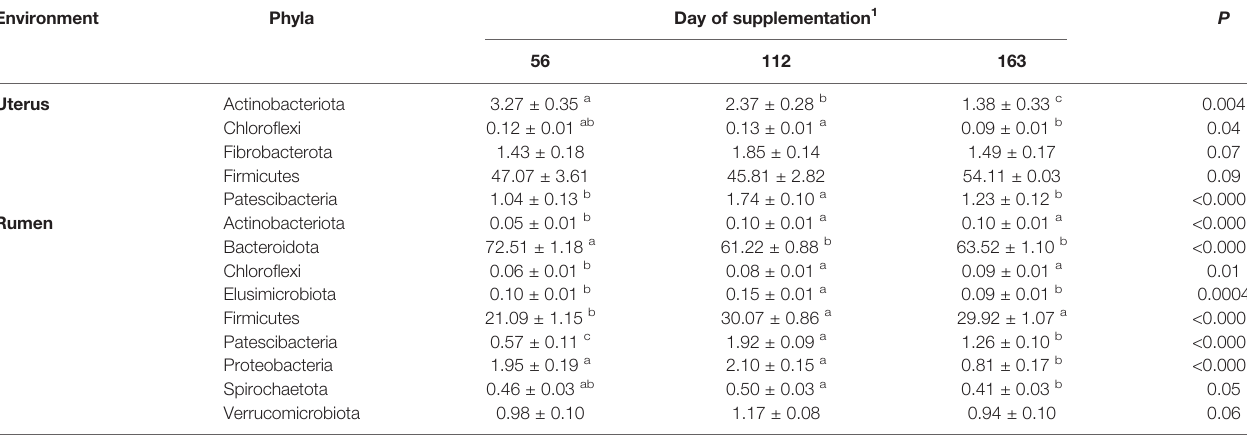
TABLE 4 | Bacterial phyla in the uterus and rumen impacted by day of supplementation. Environment